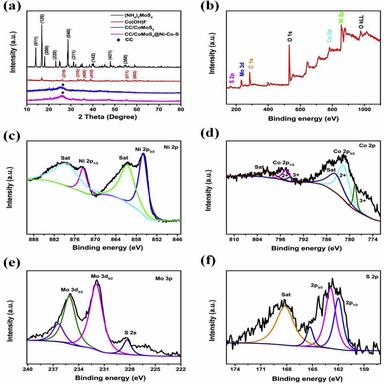
(a) XRD patterns of (NH4)2MoS4, Co(OH)F scraped from the carbon cloth substrate; CC/CoMoS4 and CC/CoMoS4@NieCoeS. XPS spectra of (b) the survey spectrum, (c) Ni 2p; (d) Co 2p; (e) Mo 3d and (f) S 2p of the CoMoS4@NieCoeS.